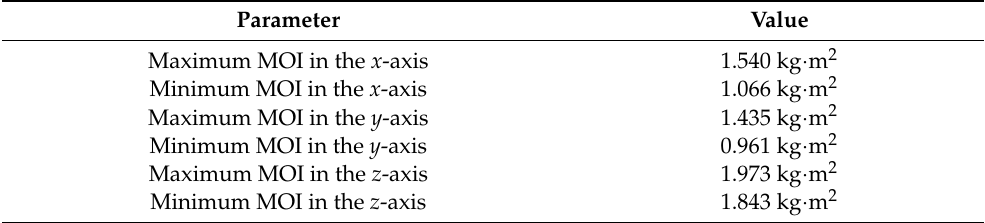
Table 2. Range of MOIs in three